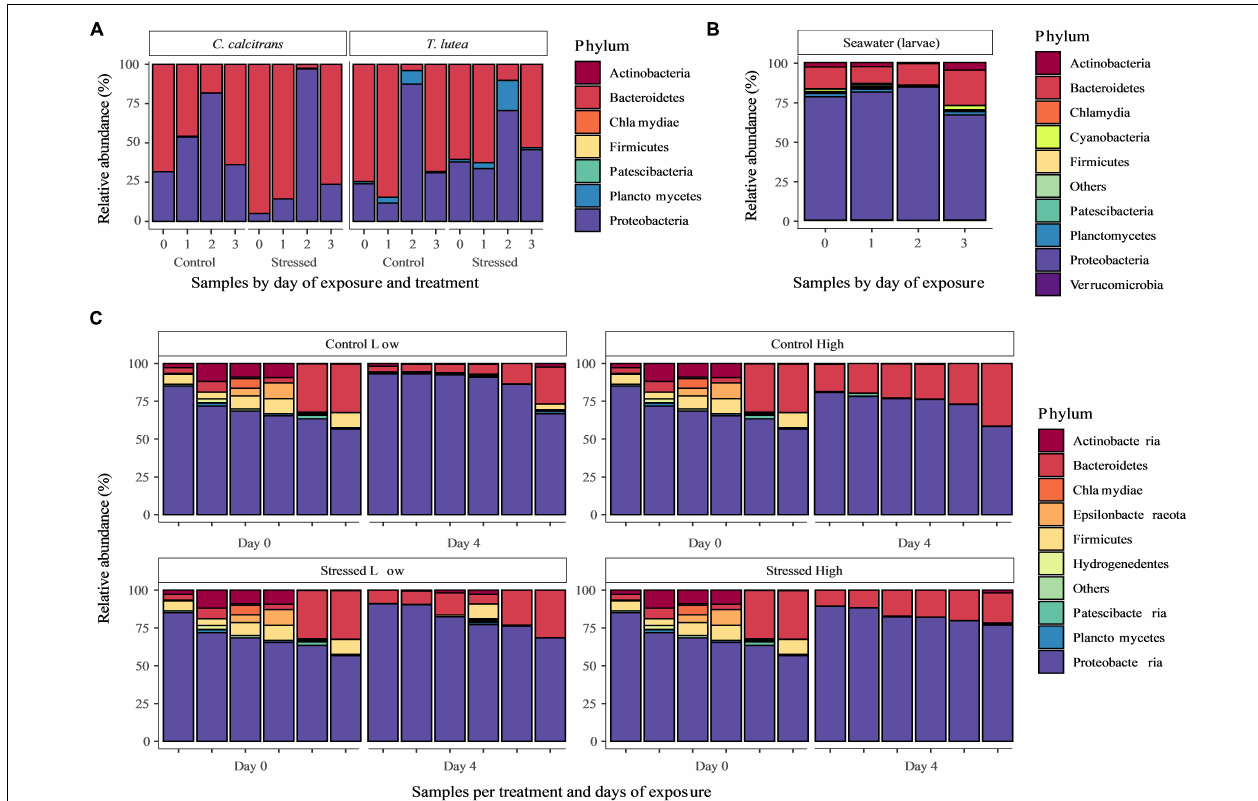
FIGURE 5 | The taxonomic composition, expressed as relative abundance in %, of microbiomes associated with (A) Chaetoceros calcitrans (CC) and Tisochrysis lutea (T-Iso) cultures on each day of the 96 h larval exposure under control and stressed (high pH) conditions; (B) the seawater in which oyster larvae were reared, on each day of the 96 h exposure; and (C) Pacific oyster ( Crassostrea gigas ) larvae at the start (Day 0) and at the end of the exposure (Day 4) to a low and high ration of unstressed microalgae (Control Low and Control High) and compromised algae (Stressed Low and Stressed High). Approximately 1000 larvae were collected from each tank on Day 0 and Day 4 (96 h) of the assay; each bar represents one tank ( n = 6); larval microbiome on Day 0 was quantified from one pool of healthy control larvae that were subsequently distributed across the four treatments: as a result, “Day 0” data arerepeated and presented four times to allow clearer comparison with “Day 4”